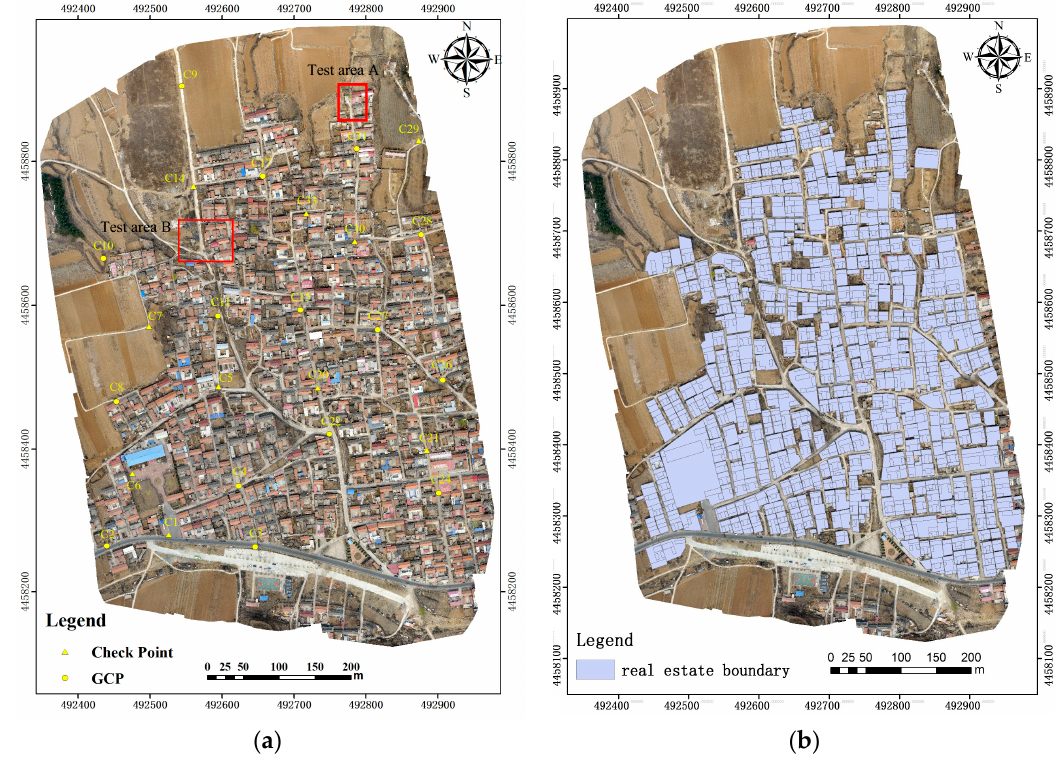
Figure 9. ( a )True digital orthophoto map; ( b ) Village cadastral map obtained by ArcGIS software vectorization. Table 1. DOM precision checklist (m).